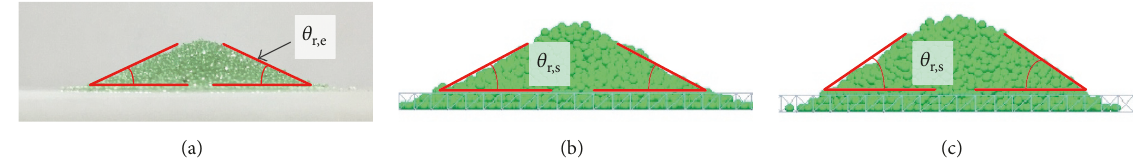
Figure 9: AOR: (a) 𝜃 r , e = 25.4 ∘ in the experiment; (b) 𝜃 r , s = 28.3 ∘ in the simulation (number 3); and (c) 𝜃 r , s = 34.8 ∘ in the simulation (number 4).